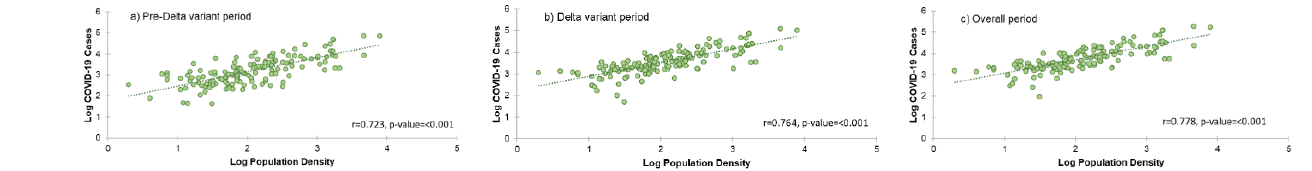
Figure 3. Correlation between absolute population and COVID-19 cases, ( a ) Pre-Delta variant period, ( b ) Delta variant period, ( c ) Overall period.